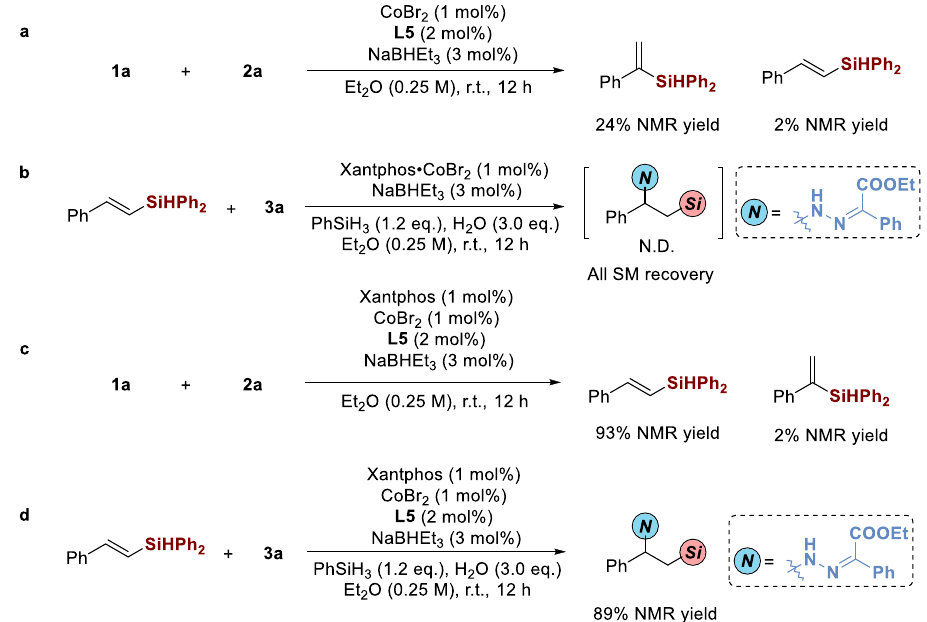
Fig. 9 Control experiments. a Investigation of hydrosilylation step using CoBr 2 and L5 . b Investigation of hydrohydrazidation step using Xantphos (cid:129) CoBr 2 . c Investigation of hydrosilylation step using a combination of Xantphos, L5 , and CoBr 2 . d Investigation of hydrosilylation step using a combination of Xantphos, L5 , and CoBr 2 .